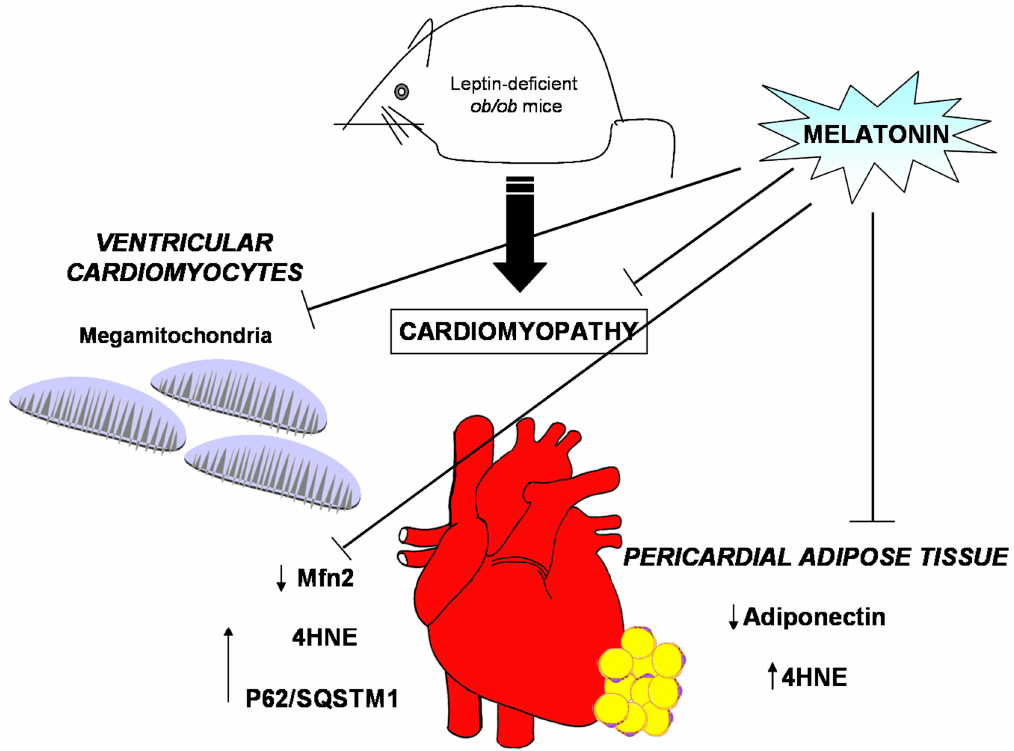
Figure 7. Obesity alterations and melatonin protective effects at both heart and pericardial adipose tissue level. Leptin deficient ob / ob mice presented, in ventricular cardiomyocytes, mitochondria with